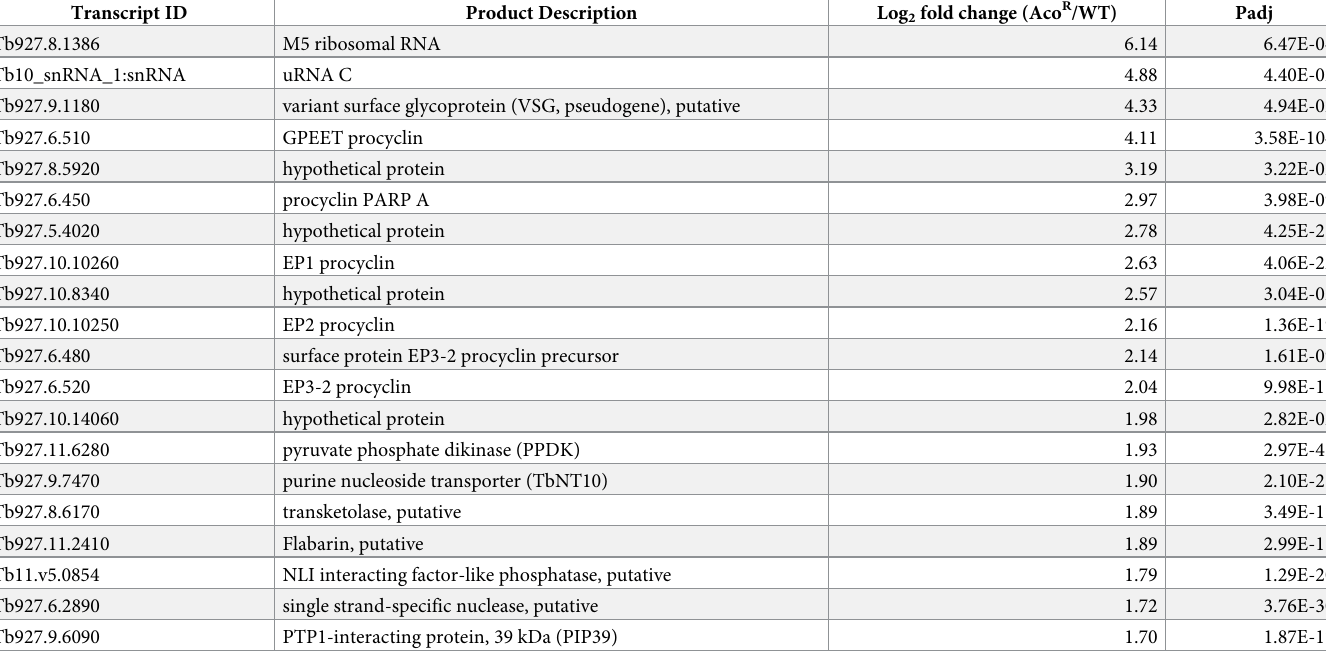
Table 1. Top 20 genes with significantly increased abundance in Aco R cells. Only one example shown for repeated genes. For full results see S1